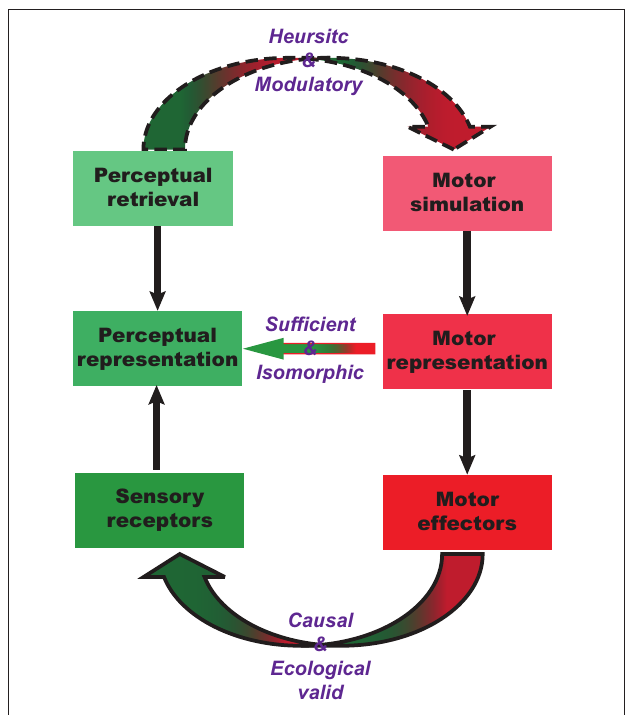
FIGURE 3 | Sufficiency and necessity between motor simulation and perceptual estimation. The characteristics of the proposed motor simulation and perceptual estimation processes, and the nature of motor involvement during perceptual tasks. The internal motor simulation can take a similar path as motor preparation to derive a corresponding motor representation that in turn derives associated perceptual representations in a one-to-one fashion. Such one-to-one mapping is the same as the one in the external connections between the similar motor action and perceptual consequences. In the other direction, when the perceptual representation is needed, different paths can be taken. It can rely on memory retrieval to directly recreate the perceptual representation. It can also take another less demanding path that relies on the motor simulation to derive the associated perceptual